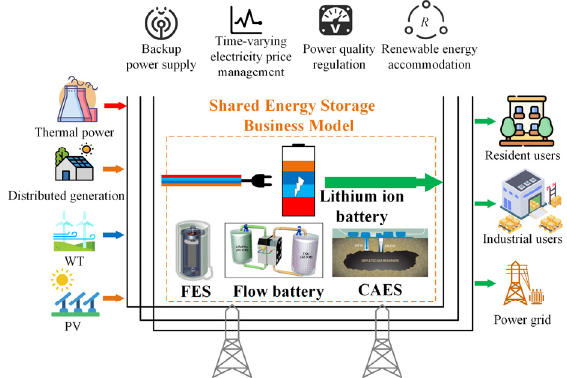
Figure 1. Schematic diagram of SES business model.